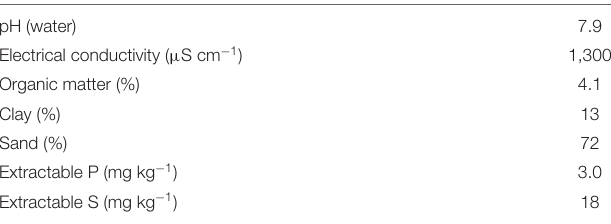
TABLE 1 | Physicochemical properties of the soil used in the experiment.